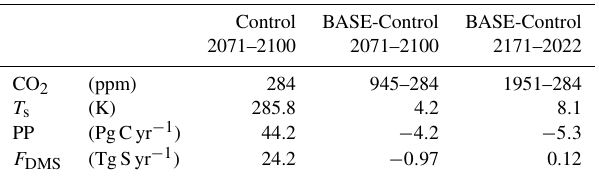
Table 2. Global mean atmospheric CO 2 concentration, surface tem- perature ( T s ), marine primary production (PP), and sea–air DMS fluxes ( F DMS ) in the control run and changes in experiment BASE relative to the control